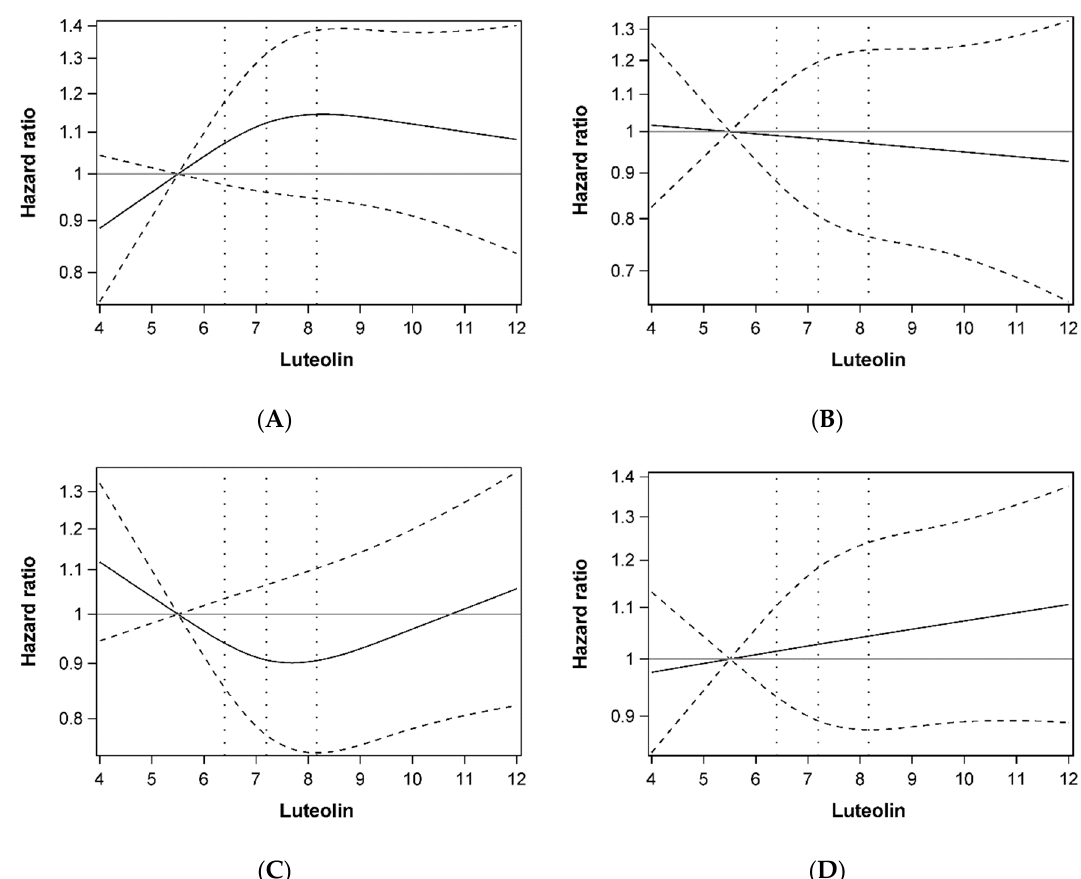
Figure 2. Dose-response relationship plots of the association between luteolin concentration (ng/mL) and overall mortality ( A ), colorectal cancer specific mortality ( B ), colorectal cancer recurrence ( C ), and disease-free survival ( D ). Hazard ratios were estimated using restricted cubic-spline proportional hazard models with three knots placed at the 10th, 50th, and 90th percentiles of luteolin concentration. The 10th percentile of luteolin concentration was treated as the reference level, and 25th, 50th, and 75th percentile were shown as dashed vertical lines. Table 2. Association of serum genistein and luteolin concentrations with long-term outcomes in CRC patients 1 .